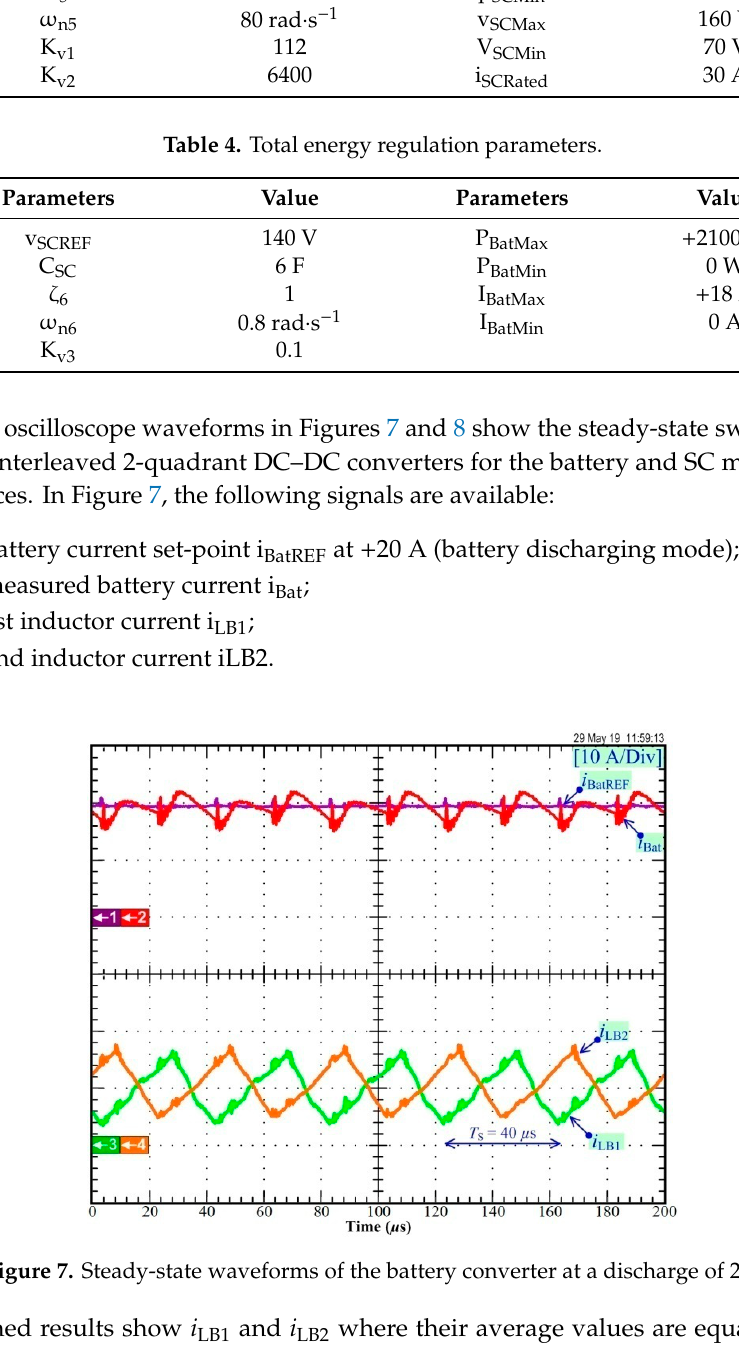
Figure 8. Steady-state waveforms of the SC converter at − 15 A. In Figure 9, it is shown the dynamics response when the battery reference i BatREF increases instantaneously from initial +5 A to final +15 A. The following signals are available: • Ch1: the battery reference i BatREF ;